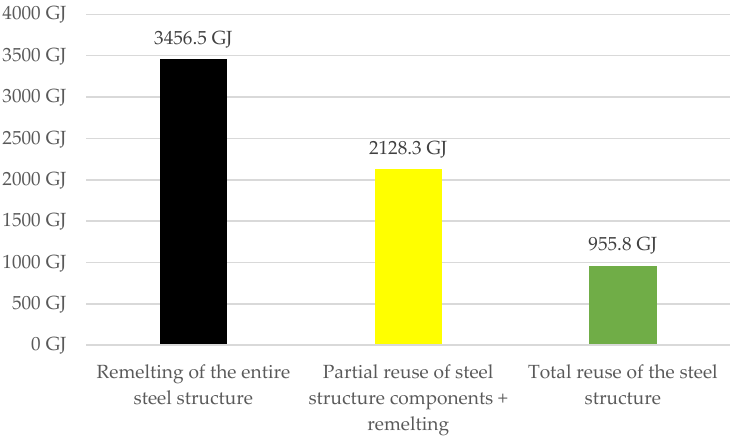
Figure 11. Primary Energy Use in three scenarios [GJ].